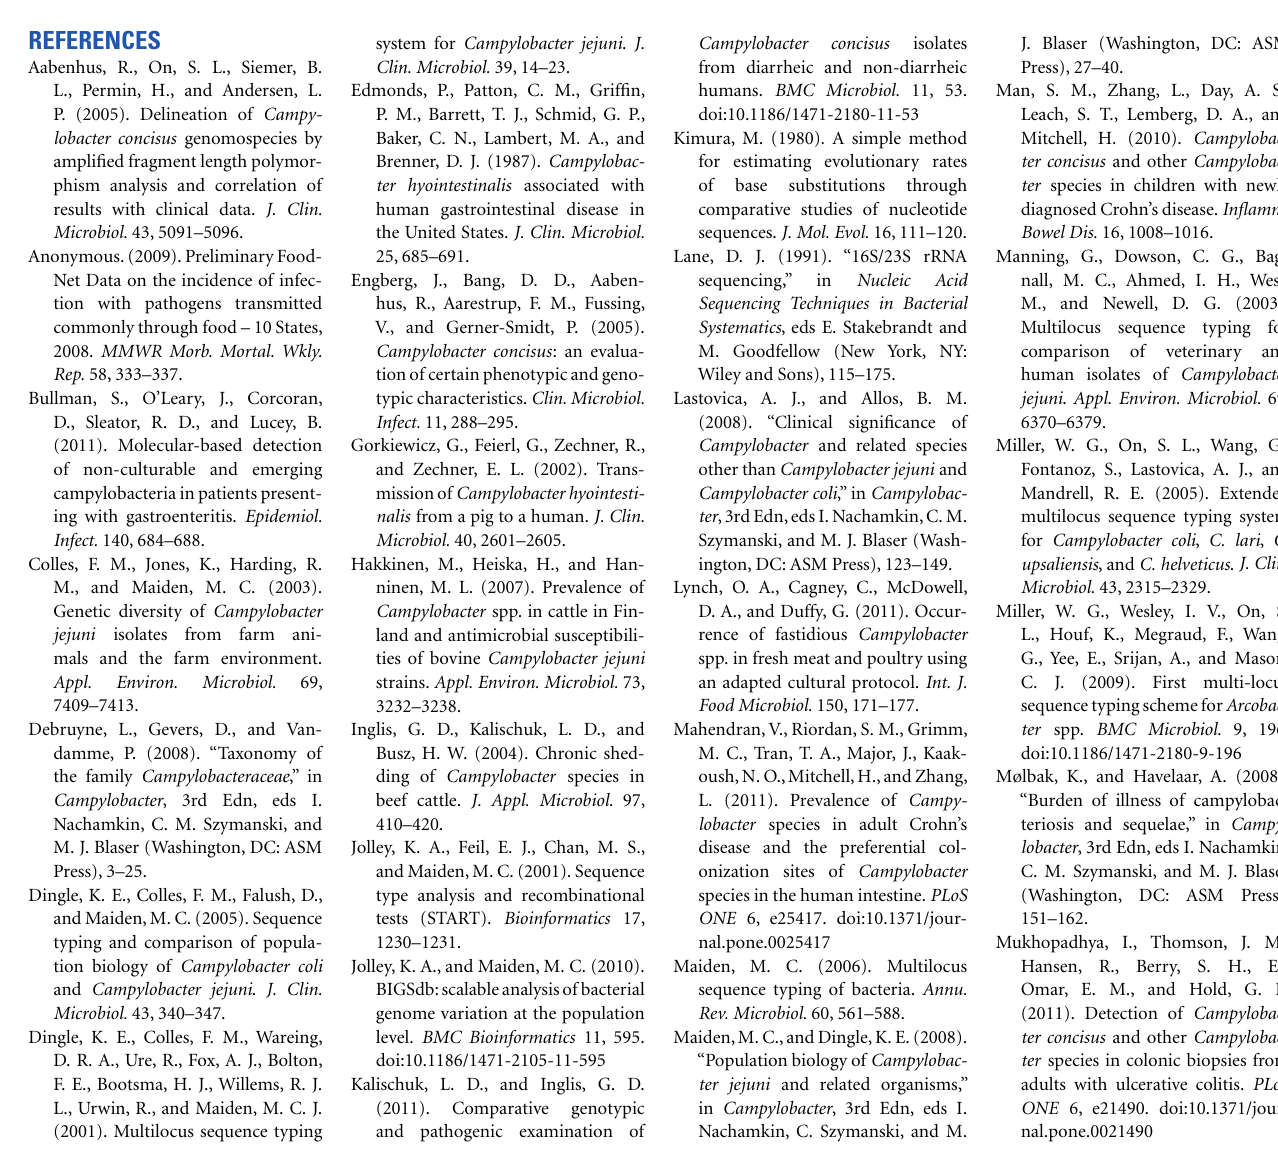
Table S1 | Campylobacter strains typed in this